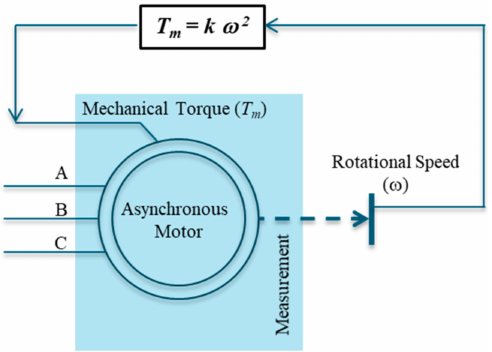
Figure 3. The typical simplified model of a motor/pump in an electrical system